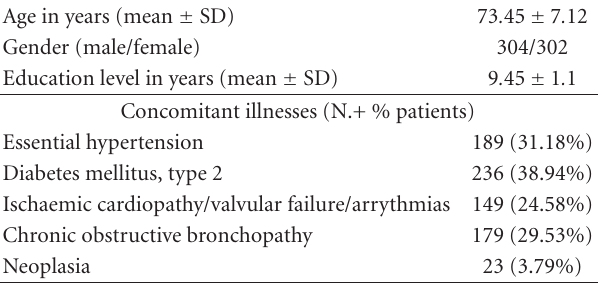
Table 1: Baseline characteristics of